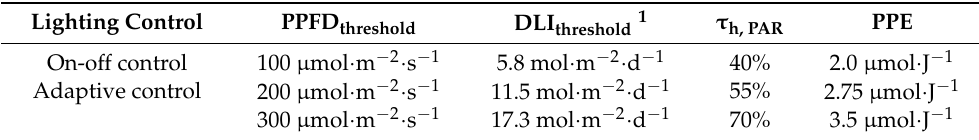
Table 1. Values used in the parametric study for the greenhouse cultivation period. Lighting